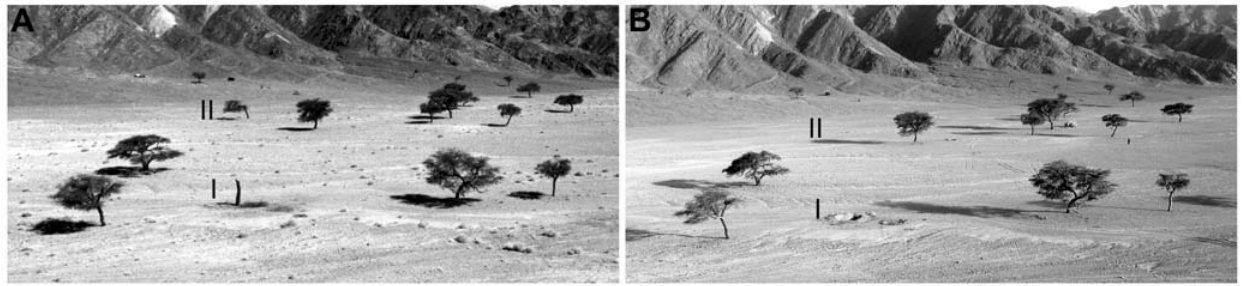
Figure 5. Changes in Wadi Gaetri between A 1996 and B 2003. I: In 2003 a hole in the ground is all that testifies to the presence of the stump (1996). II: A green tree has already lost half of its canopy. In 2003 this tree is completely gone, suggesting live felling for charcoal